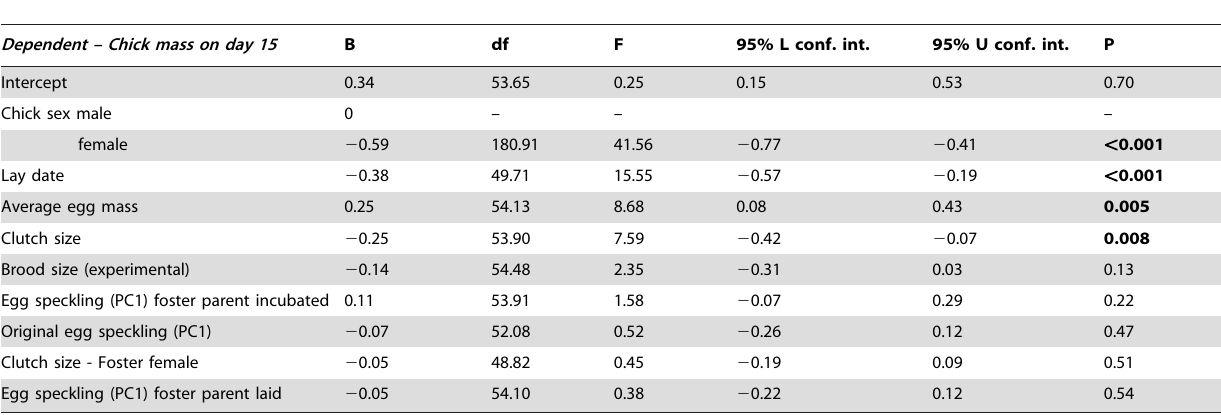
Table 4. DAY 15. Linear Mixed-effects Model showing no effect of egg speckling on chick mass on day 15.